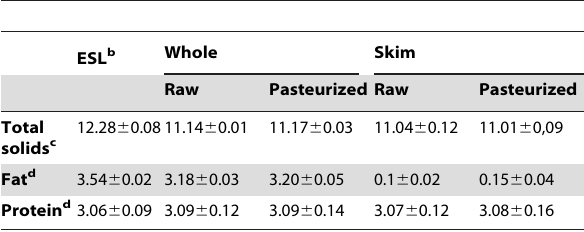
Table 1. Gross composition of milk used in the HydH5 and its derivative fusion proteins antistaphyloccal assays a